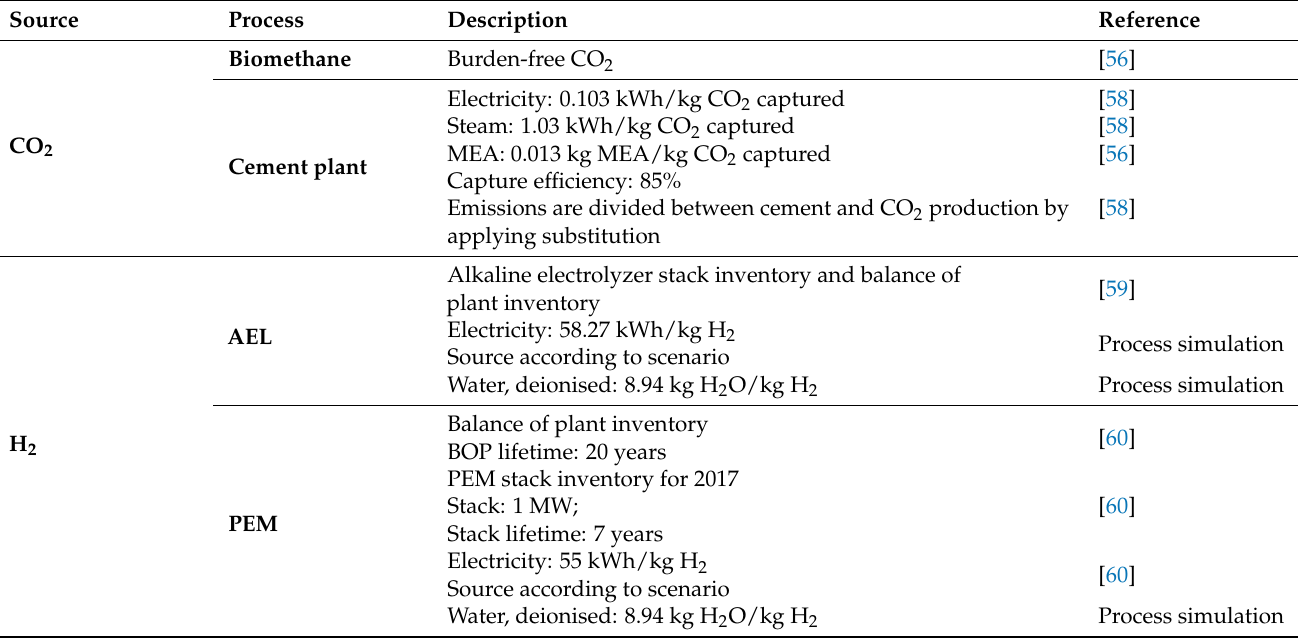
Table 6. Boundary conditions used for the life cycle